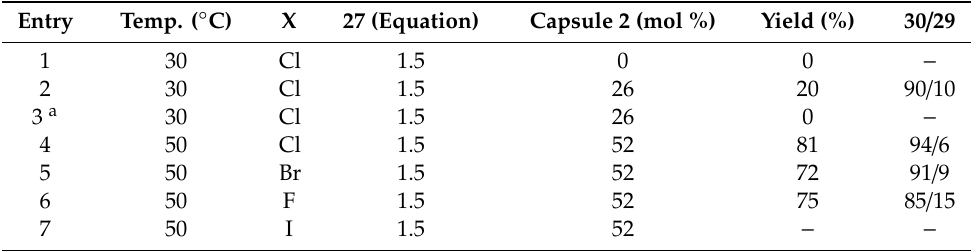
Table 6. Optimization of Friedel–Crafts reaction.